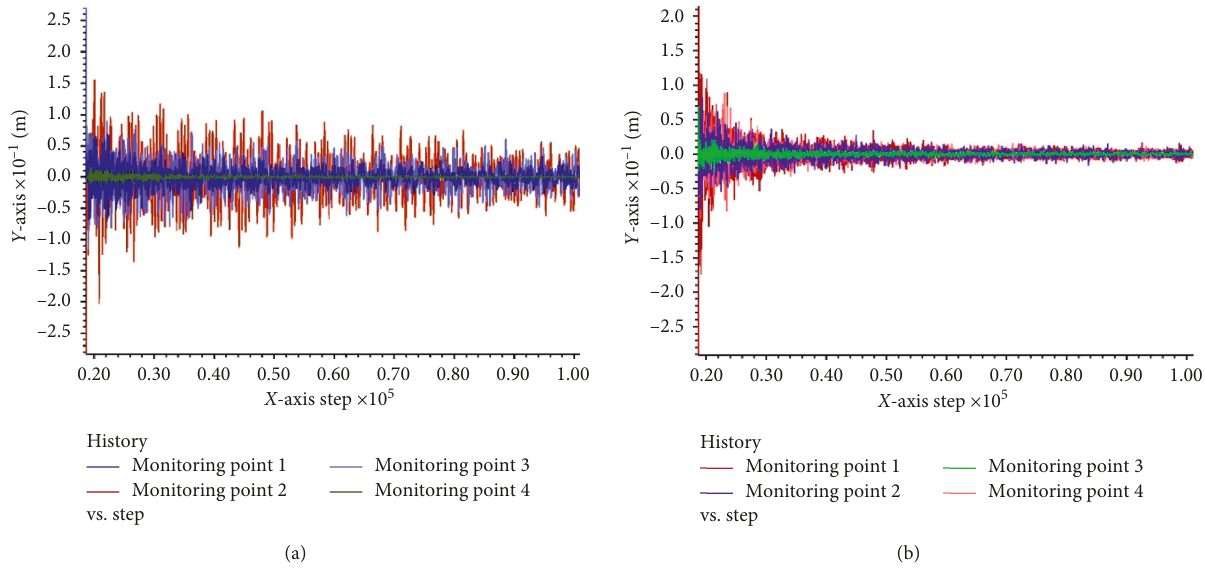
Figure 16: Velocity response diagram for six dynamic loads. (a) X -directional deformation velocity and (b) Z -directional deformation